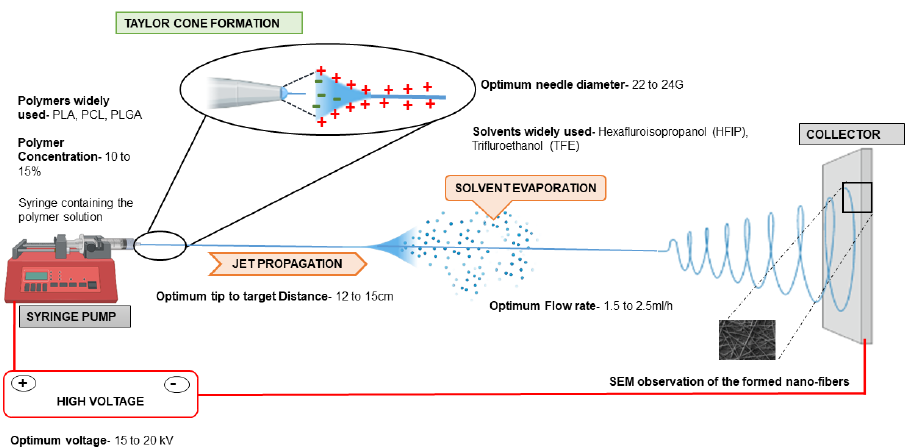
Figure 3. Optimum electrospinning parameters used for liver tissue engineering are provided. Polymers such as PLA, PCL and PLGA are most commonly used at a concentration of 10-15% dissolved in solvents such as HFIP, TFE, etc. The needle used for electrospinning has a diameter of 20-24G and the tip to target distance should be about 12-15cm. The voltage of the equipment should be maintained at 15-20kV. The flow rate of the polymers should be 1.5 to 2.5 ml/hour. With these parameters, the obtained fiber diameter and porosity is approximately around 400-450nm and 40µm, respectively, and is suitable for hepatic cells. PLA: Polylactic acid; PCL: Polycaprolactone; PLGA: Polylactic-co-glycolic acid; HFIP: Hexaflouro-isopropanol; TFE: Trifluroethanol (unpublished original pictures by authors created using Biorender.com) . PCL is another widely used polymer for liver tissue engineering applications. PCL is effective in facilitating cellular growth and proliferation. However, to overcome the hydrophobicity of this polymer and also to improve its mechanical properties, this polymer is also combined with natural polymers and/or tissue matrix proteins. PCL combined with collagen and PES polymer has shown